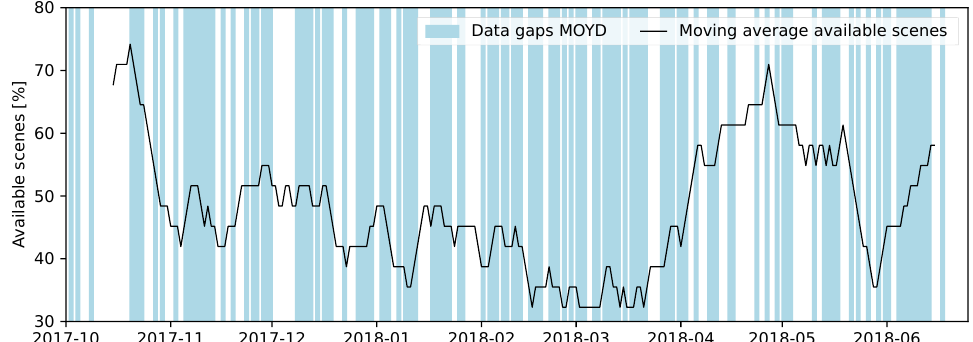
Figure 8. Data gaps of MOYD (blue) and moving average (window size of 30 days) of the percentage of available MOYD snow cover